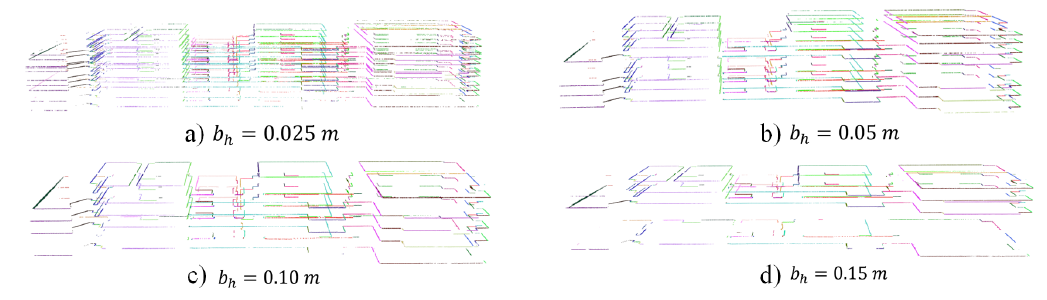
Figure 21. The experimental results for different values of search radius s r : ( a ) Over-segmentation; ( b , c ) well-segmented; ( d )